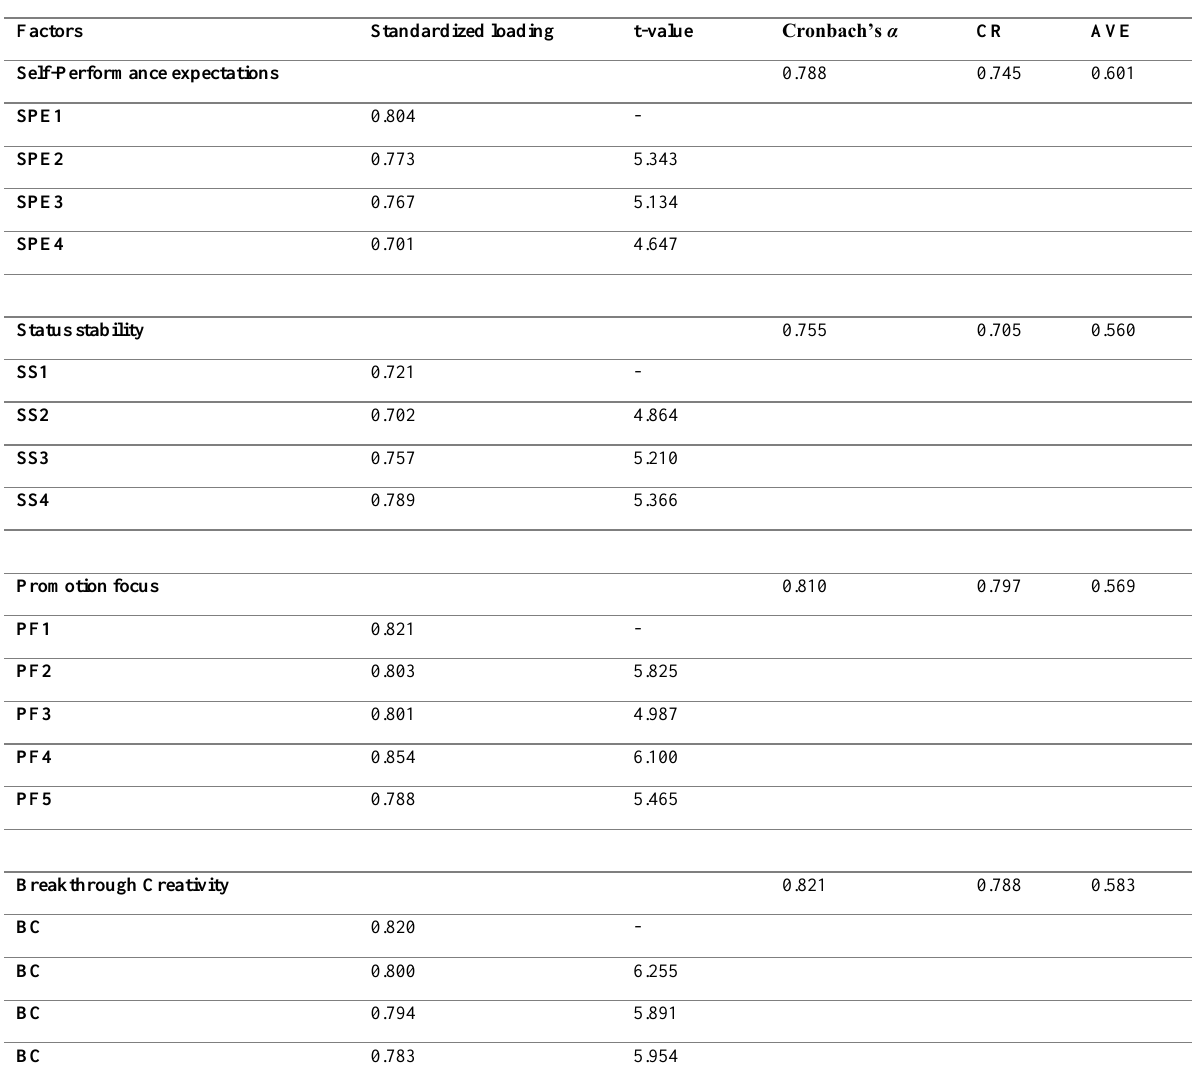
Table 3: Measurement